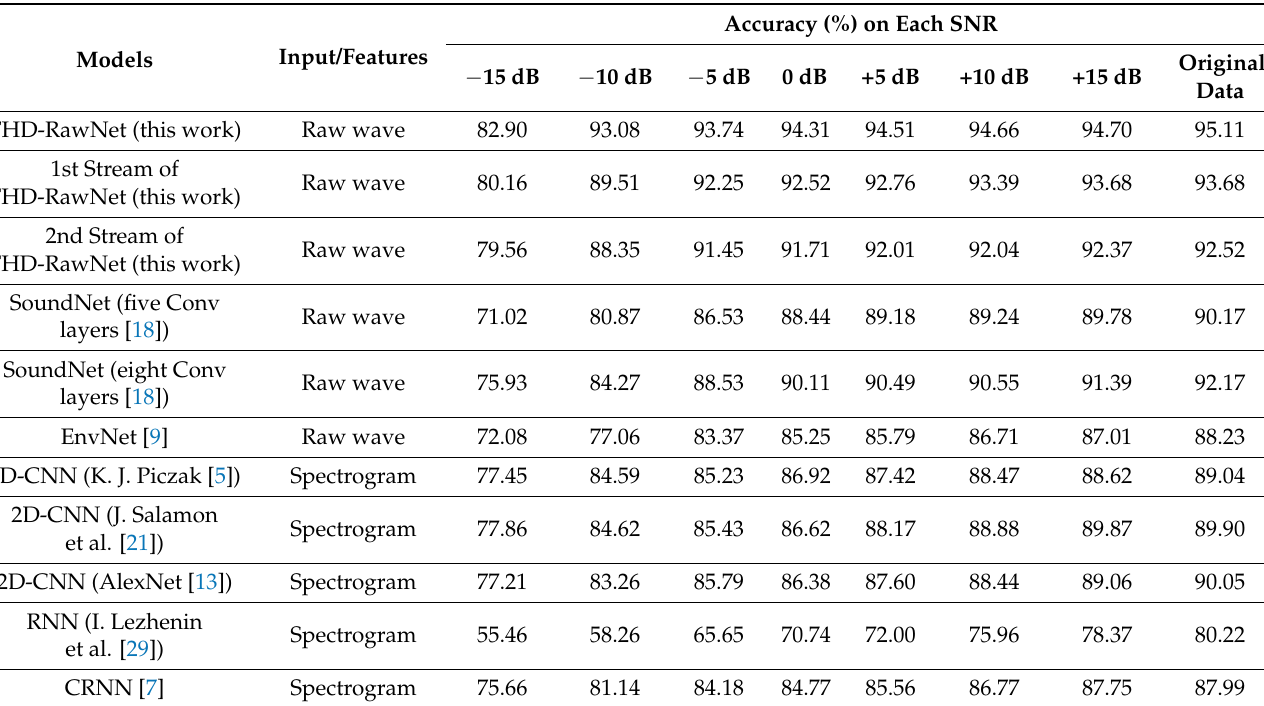
Table 6. Results of proposed THD-RawNet and baseline models across various levels of